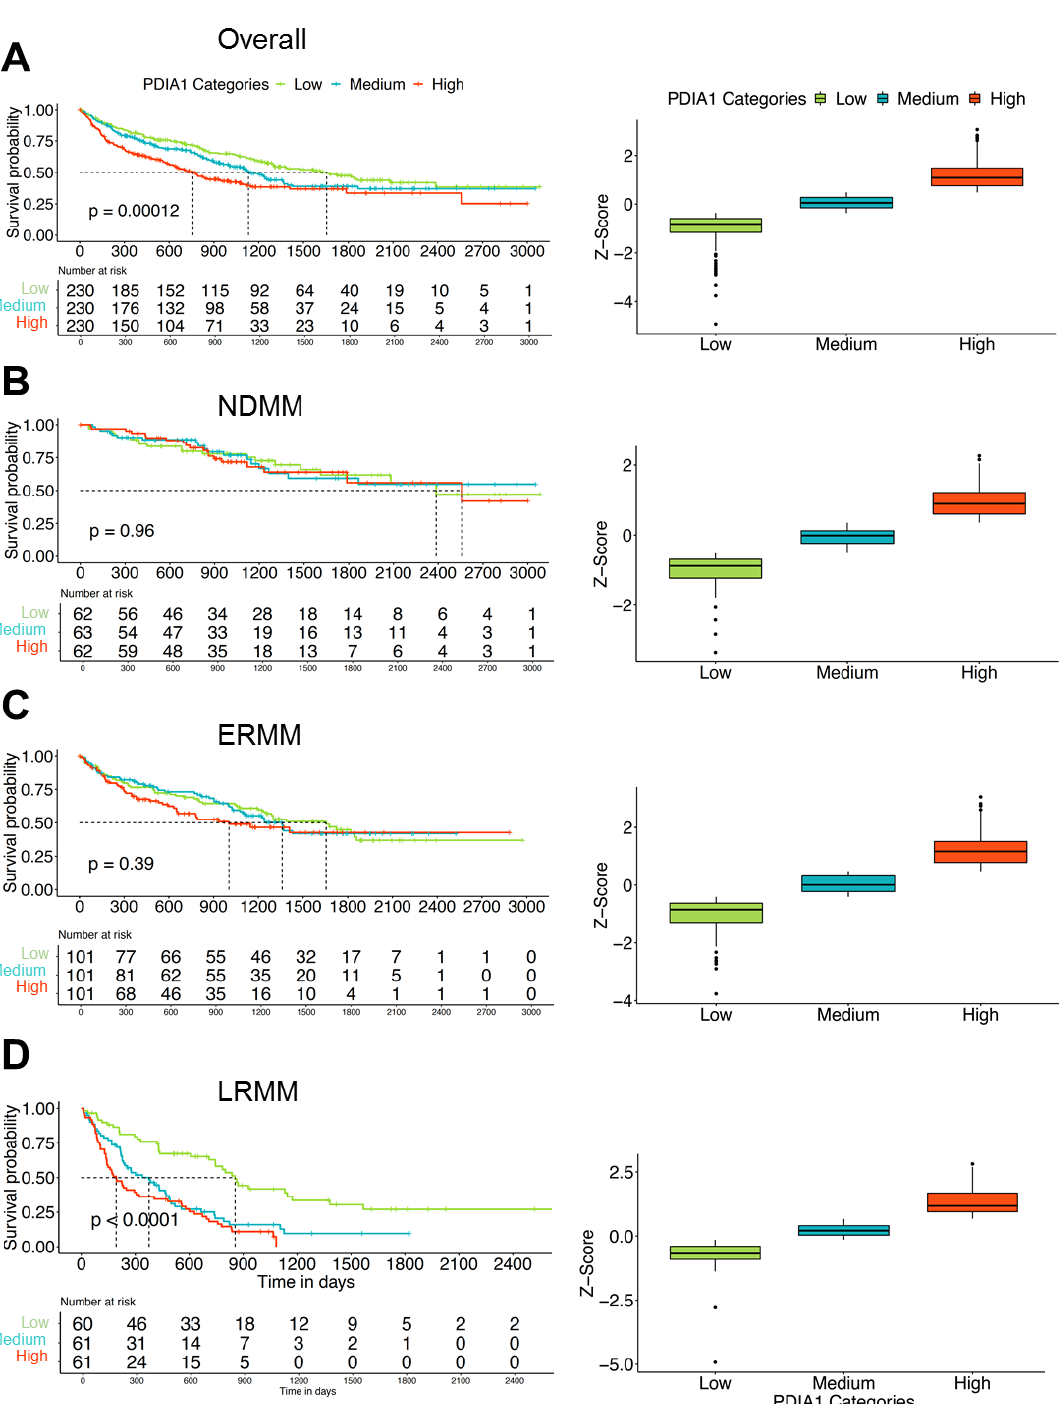
Figure 1. Expression of PDIA1 in myeloma associates with survival. CD138-purified myeloma cells from patients with multiple myeloma were subjected to RNA sequencing and survival was estimated based on Kaplan–Meier for low, medium, and high PDIA1 expression tertiles. The statistical significance for the survival curves was determined by Log-rank test. ( A ) High and medium expression resulted in inferior survival in the entire myeloma cohort. While ( B ) no significant effect on survival was seen in newly diagnosed myeloma, in ( C ) patients with early (1 – 3 prior lines of therapy) or ( D ) late relapse (>3 prior lines of therapy) medium and high PDIA1 expression tertile were associated with shorter survival. Abbreviations: NDMM—newly diagnosed multiple myeloma; ERMM—early relapse multiple myeloma; LRMM—late relapse multiple myeloma; os—overall